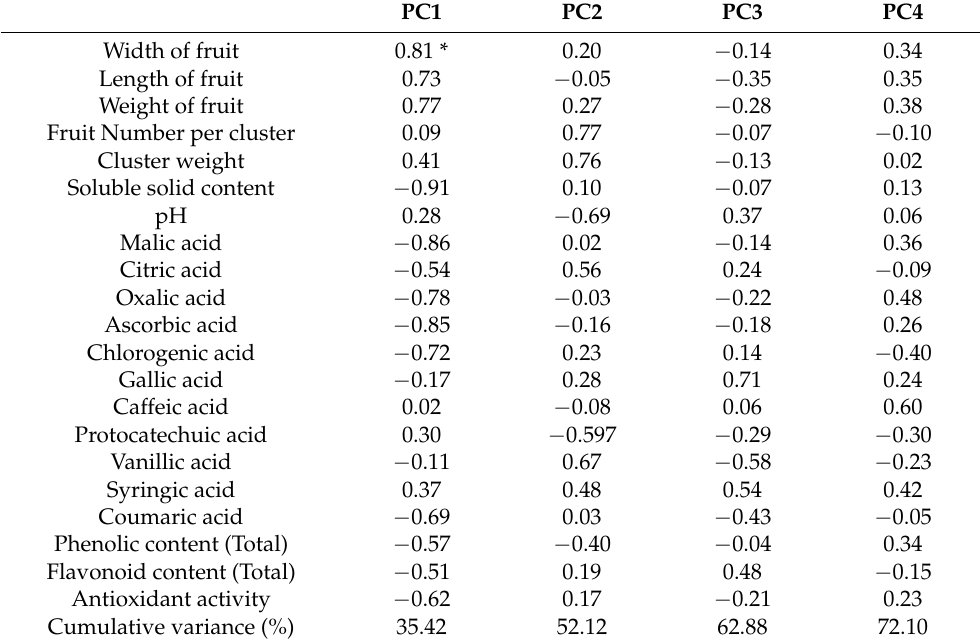
Table 4. The eigenvalues of the principal component axes from